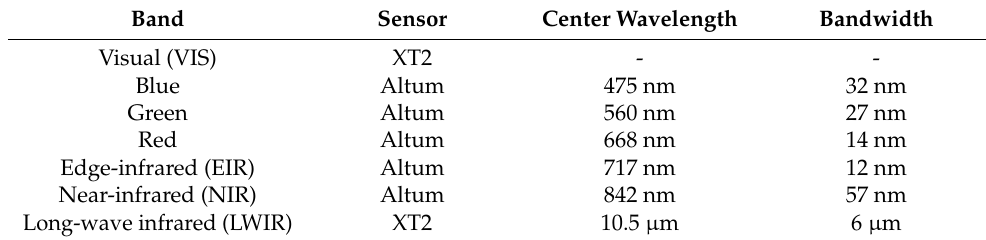
Table 1. Characteristics and associated sensor of each